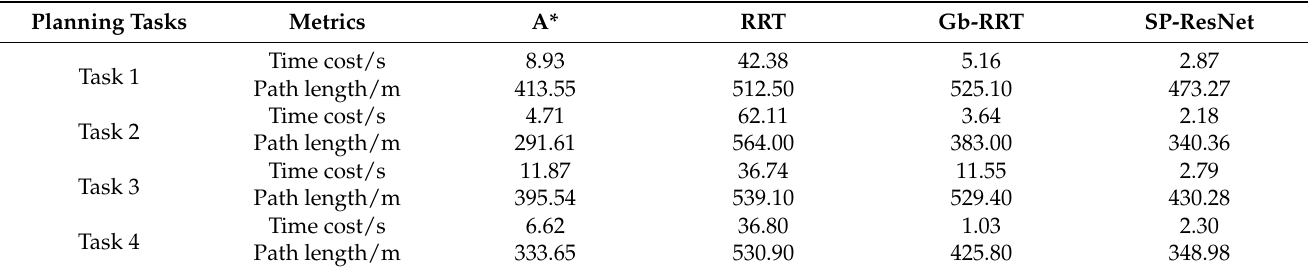
Table 3. Comparative analysis of path planning tasks on 500 × 500 m 2 maps.